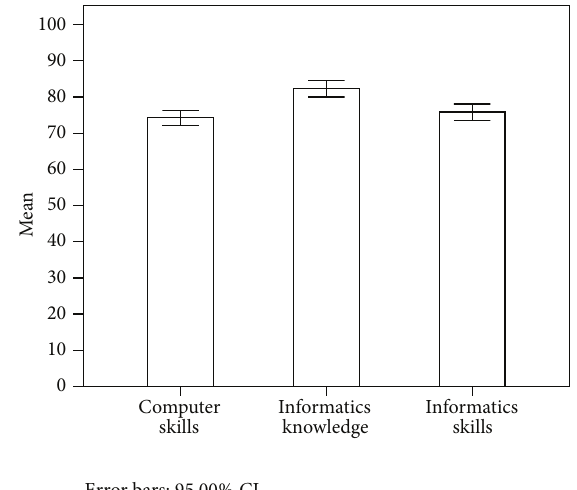
Figure 1: Difference between three domains of informatics com- petencies. Informatics knowledge was significantly higher than computer skills and informatics skills ( 𝑃 < 0.000 ). However, computer skills were not different from informatics skills ( 𝑃 = 0.313